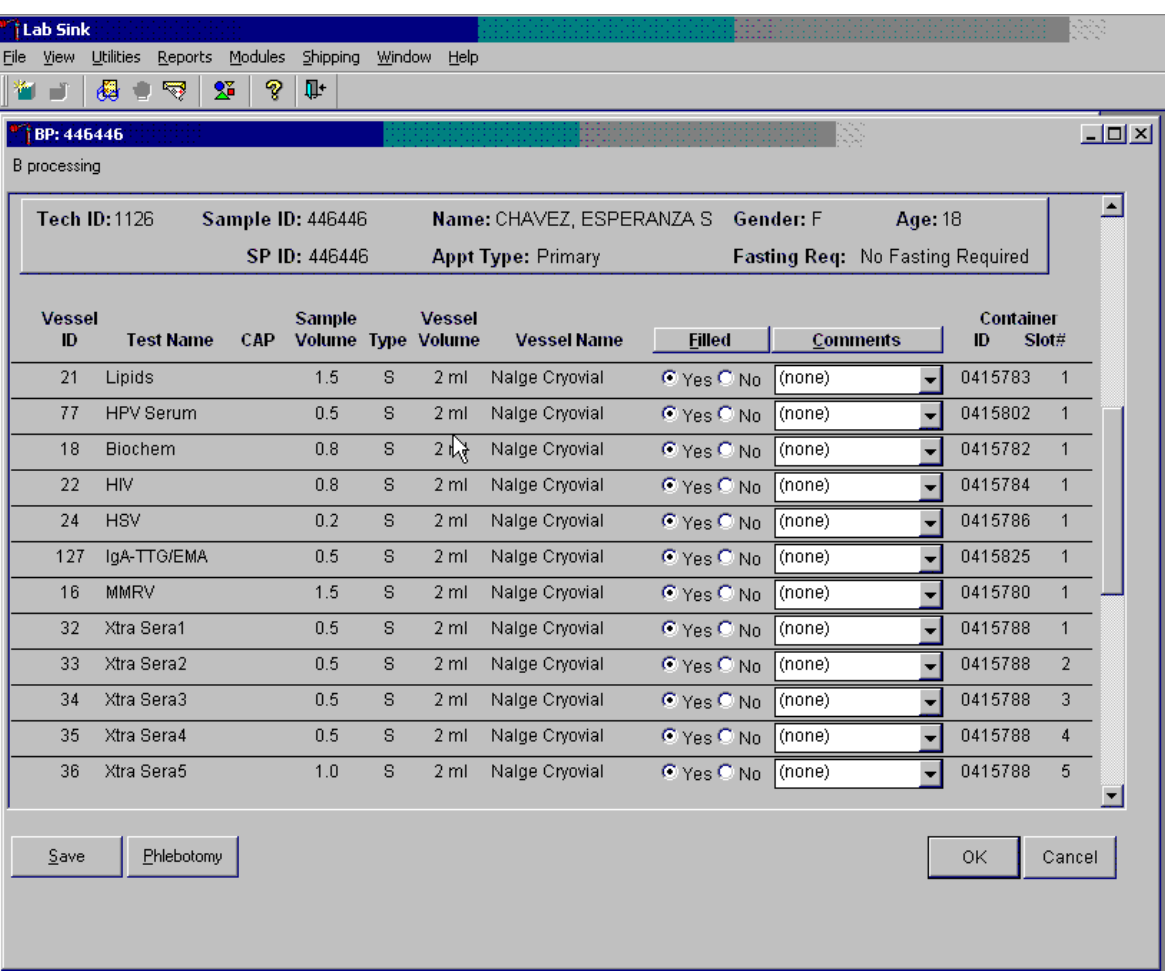
Record processing results for vessel 77 (HPV Serum) in the Blood Processing